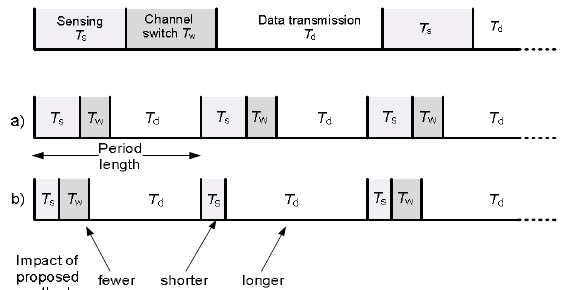
Figure 9 . Impact of the method: a) original frame b) with the intelligent